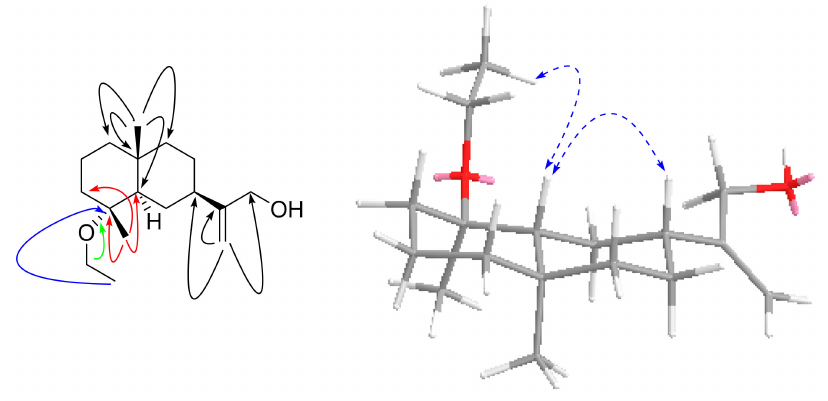
Figure 10. Key HMBC ( → ) and ROESY ( ↔ ) correlations for Compound 4 .